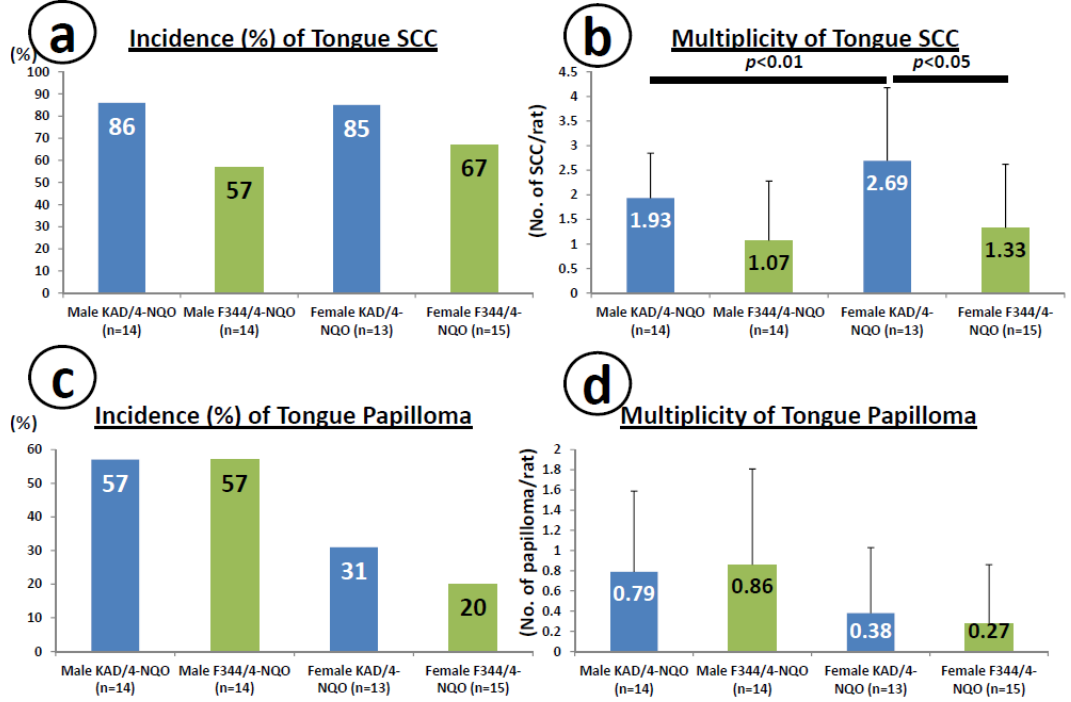
Figure 2. Incidence and multiplicity of tongue lesions in the KAD and F344/NS1c rats. ( a ) Incidence of tongue squamous cell carcinoma (SCC); ( b ) multiplicity of tongue SCC; ( c ) incidence of papilloma; ( d ) multiplicity of papilloma; ( e ) multiplicity of mild dysplasia; ( f ) multiplicity of moderate dysplasia; and ( g ) multiplicity of severe